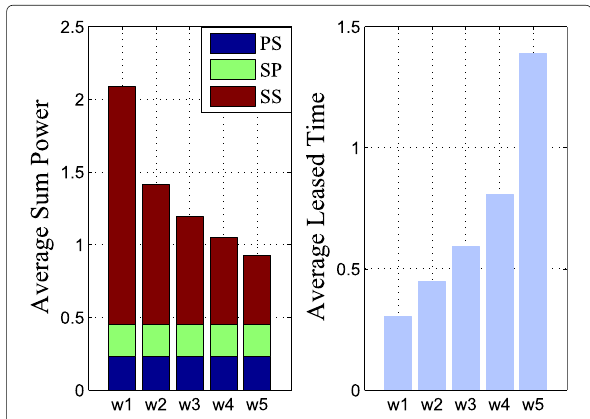
Fig. 3 The average sum power ( left ) and average leased time ( right ) with DF relay protocol. θ p = θ